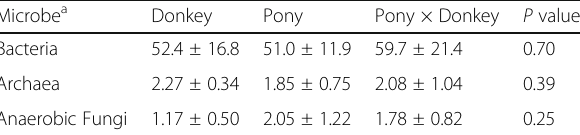
Table 1 Effect of equine type on fecal microbial concentrations